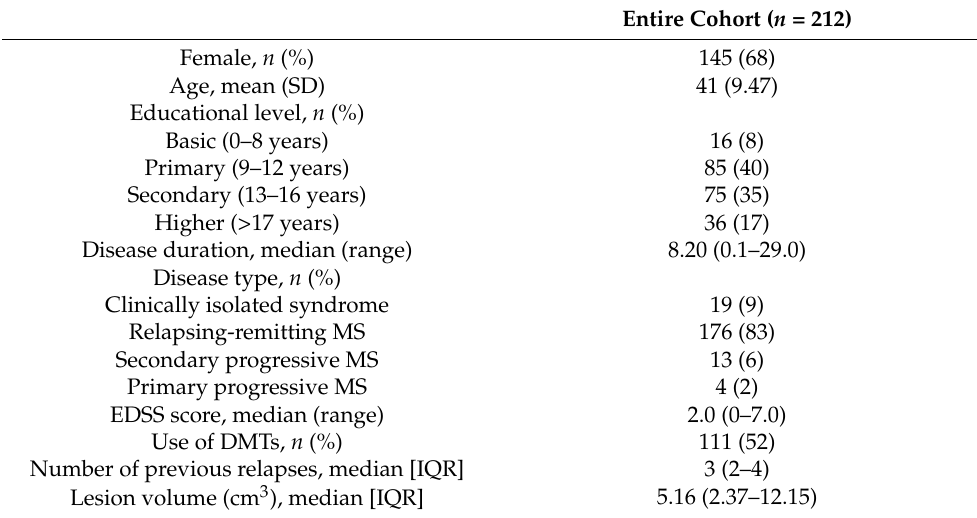
Table 1. Demographic, clinical, and MRI characteristics of MS patients at